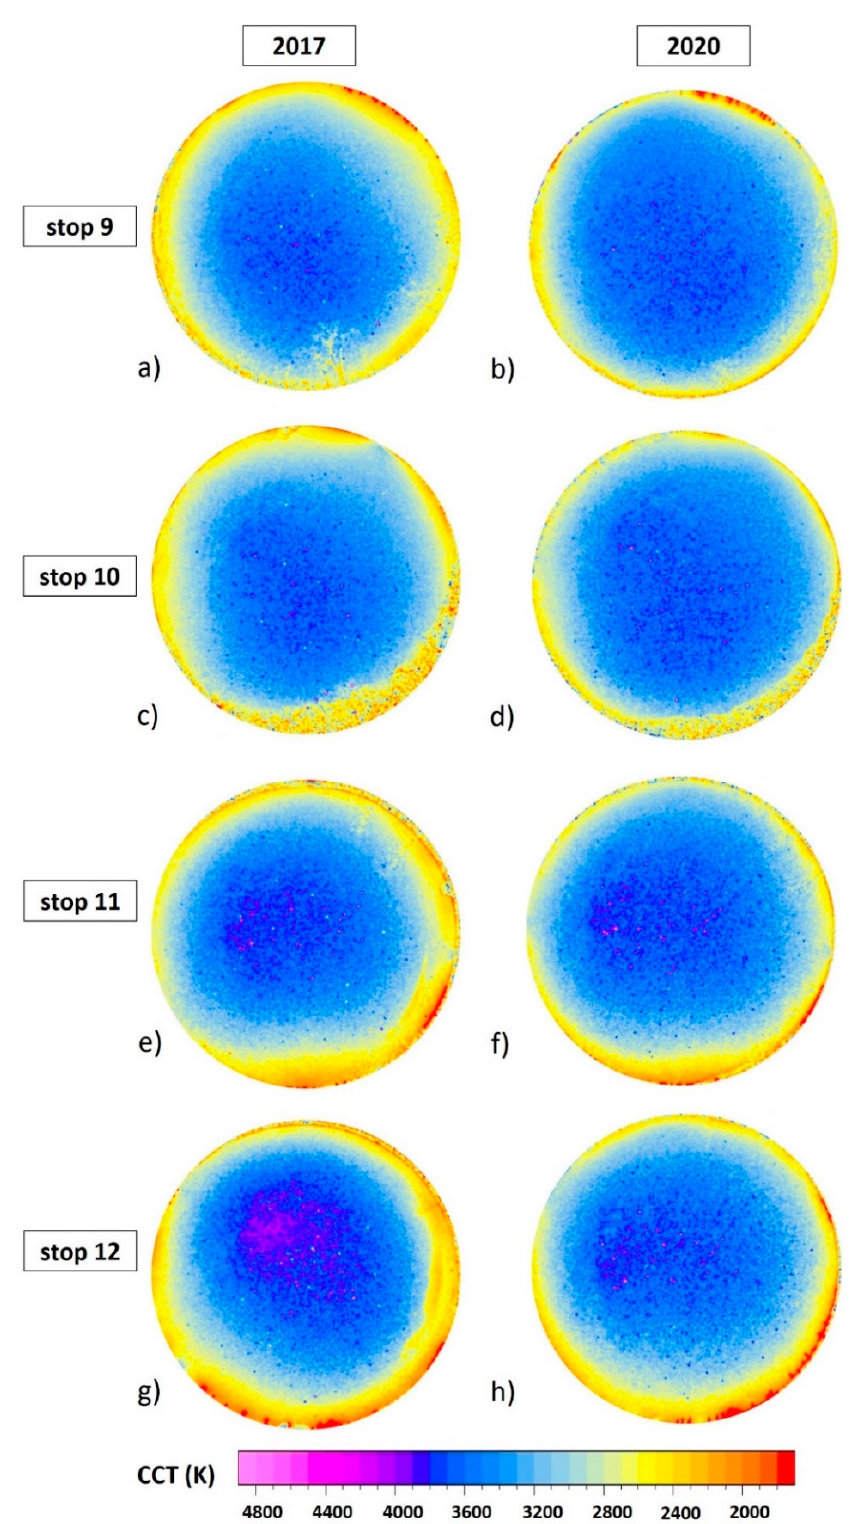
Figure A6. CCT maps for stops 9–12. ( a , c , e , g ) 2017 data, ( b , d , f , h ) 2020 data.